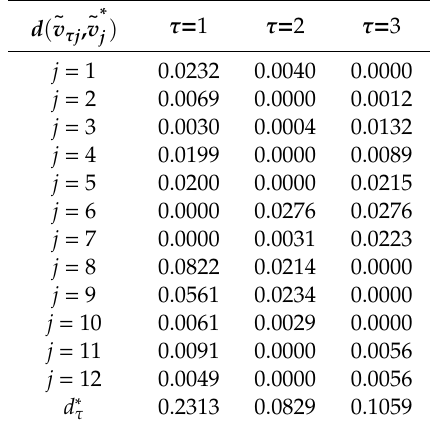
Table 13. Distance of each information system from